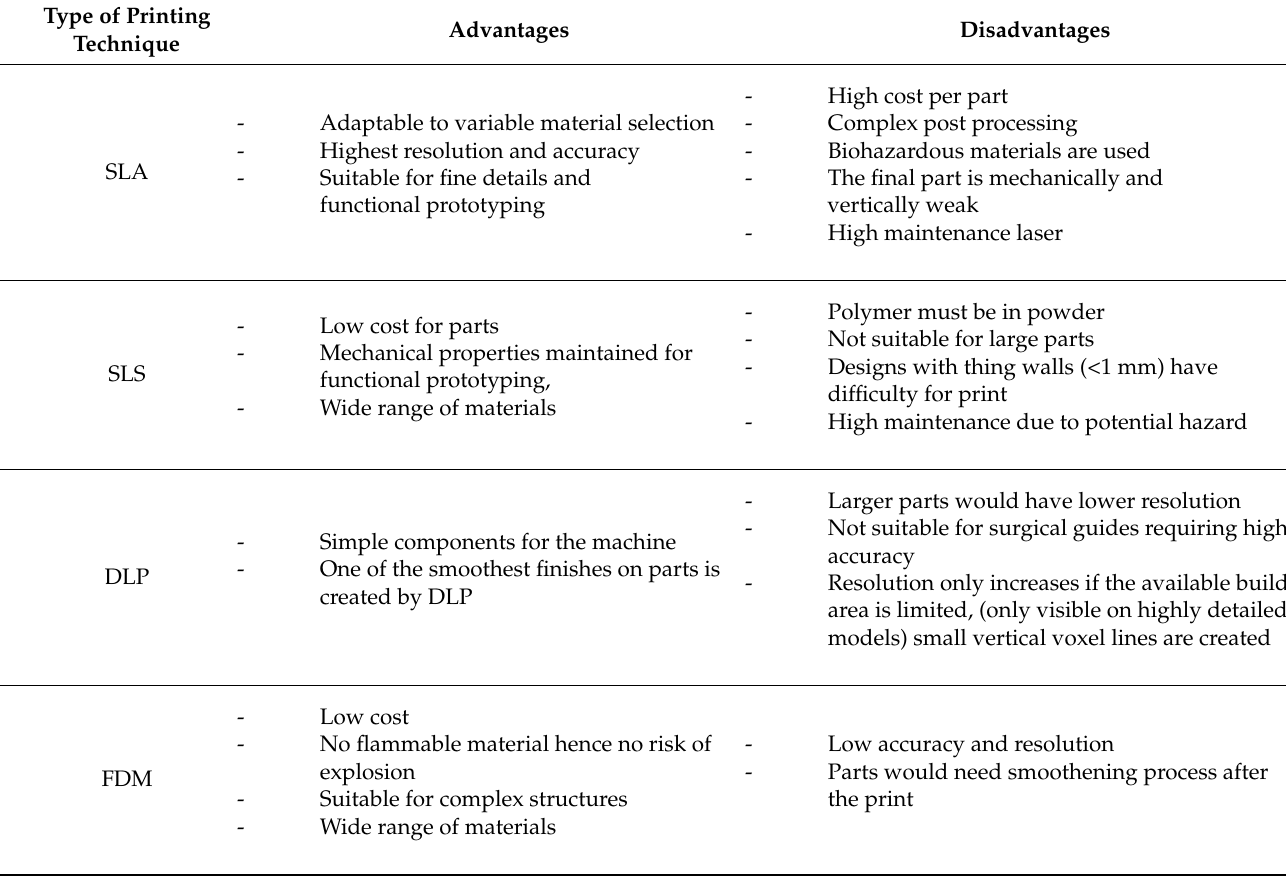
Table 1. Advantages and disadvantages of the most commonly used additive manufacturing (AM) methods utilized in dentistry